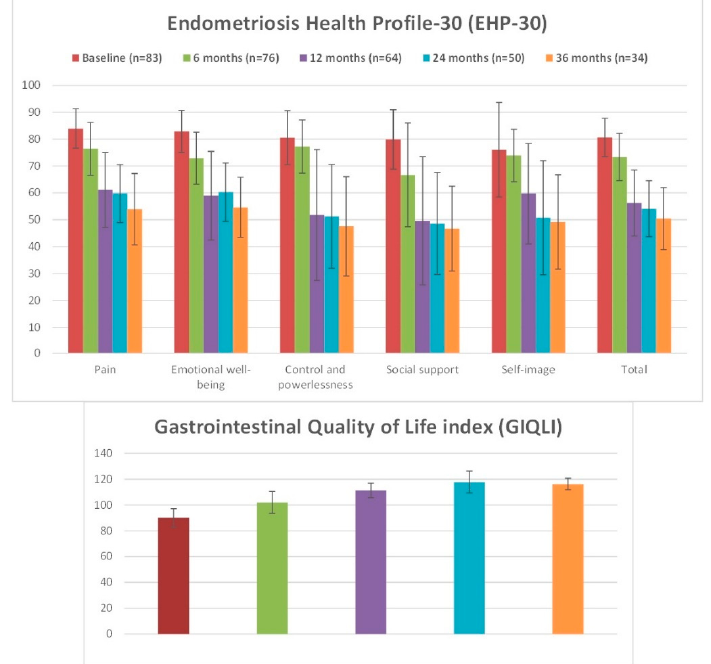
Figure 2. Representation of changes in Endometriosis Health Profile-30 (EHP-30) and Gastrointestinal Quality of Life Index (GIQLI) scores during the treatment.